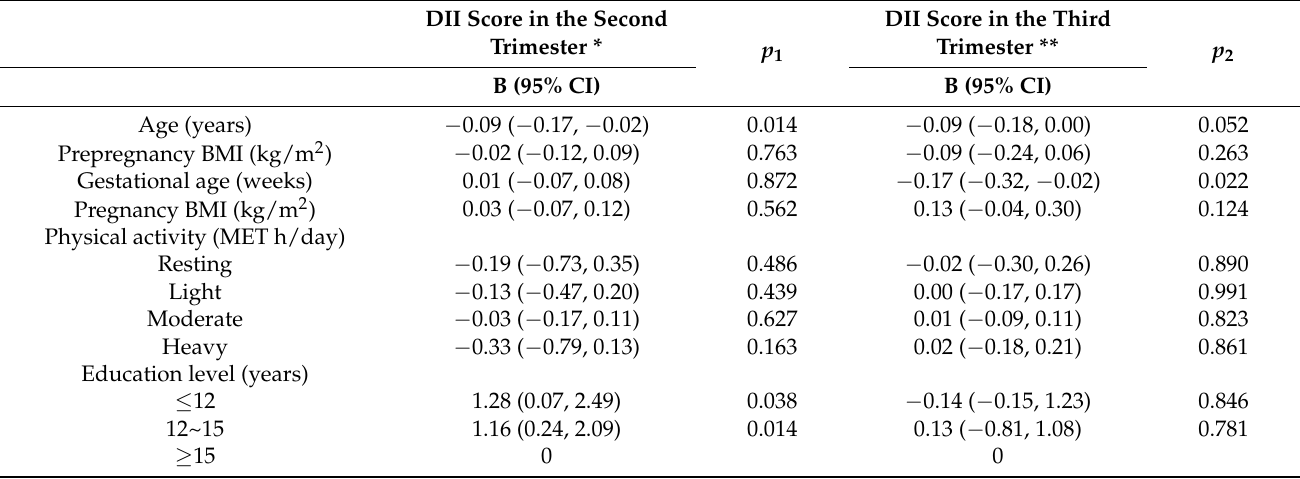
Table 2. Multivariate general linear model analysis of demographic factors and DII